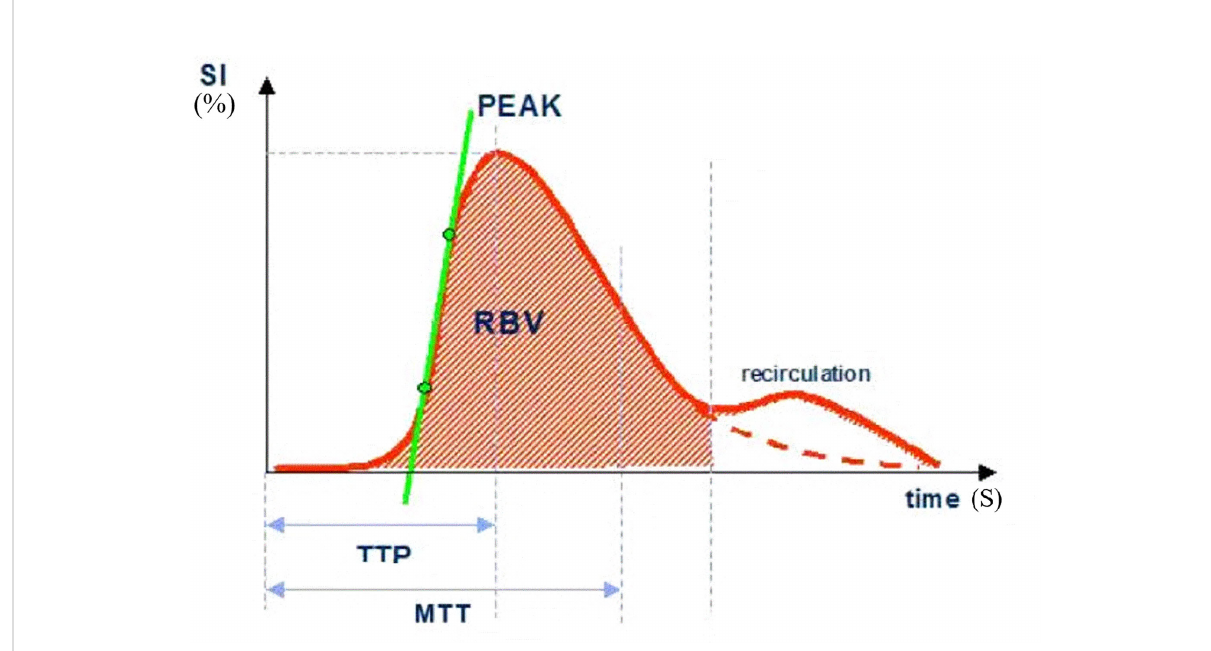
FIGURE 1 SI, signal intensity; TTP, time to peak; MTT, mean transit time; Peak, peak intensity (%); RBV, regional blood volume; RBF, regional blood fl ow